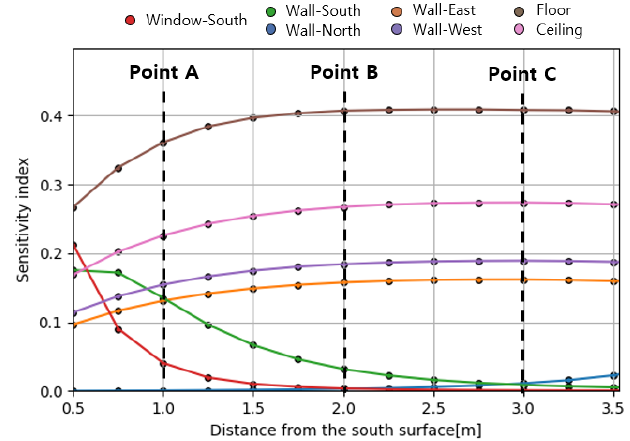
Figure 11. Results of sensitivity analysis.